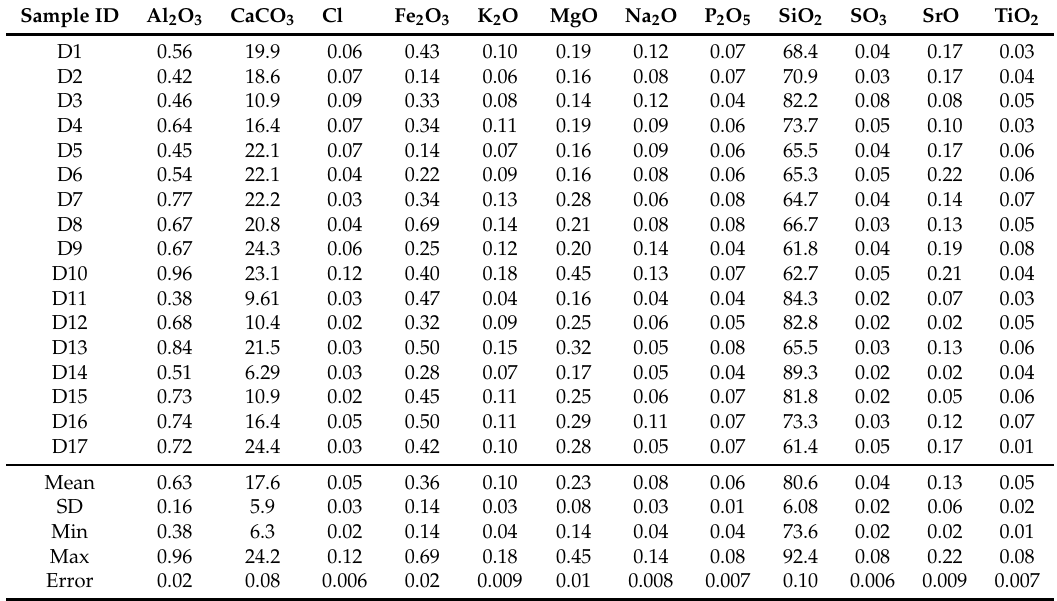
Table 1. X-ray fluorescence (XRF) analysis of the diatomite ore samples (concentrations expressed in wt % ) . Sample